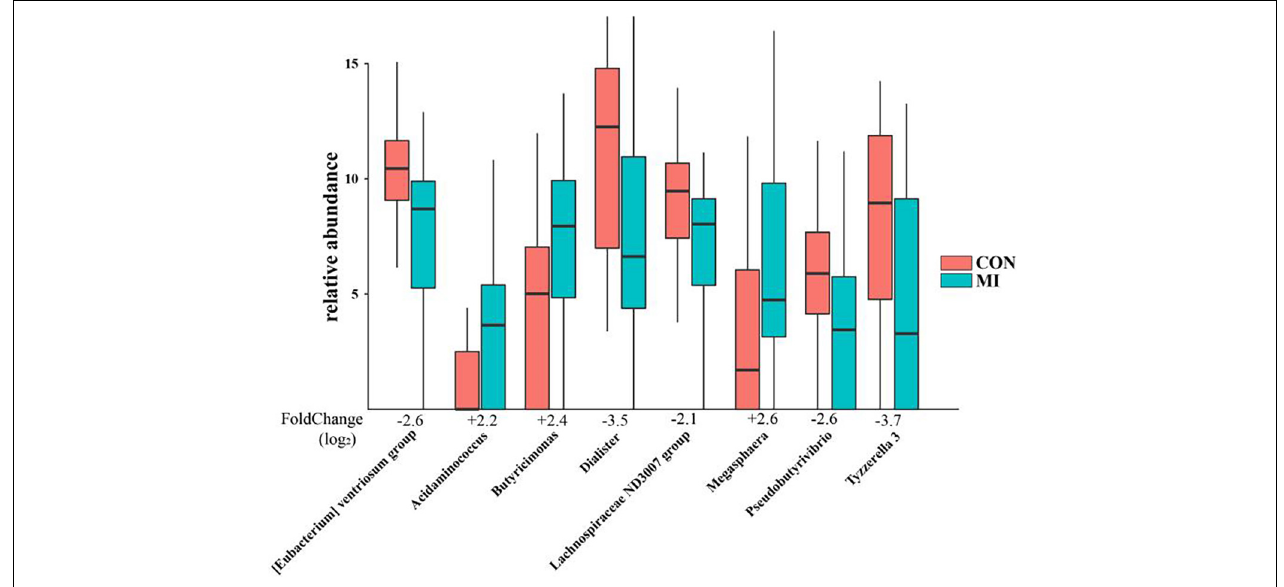
FIGURE 3 | The remarkable results of differential taxonomy expression analysis using limma algorithm between the AMI and healthy control group. MI, AMI group; CON, the healthy control